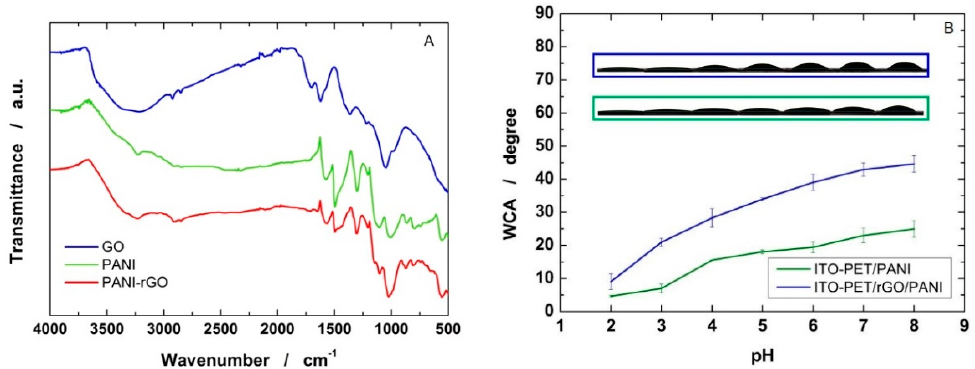
Figure 3. ( A ) FT-IR/ATR spectra of GO, PANI and PANI-rGO samples; ( B ) contact angle measure- ments on electrodes as a function of pH.